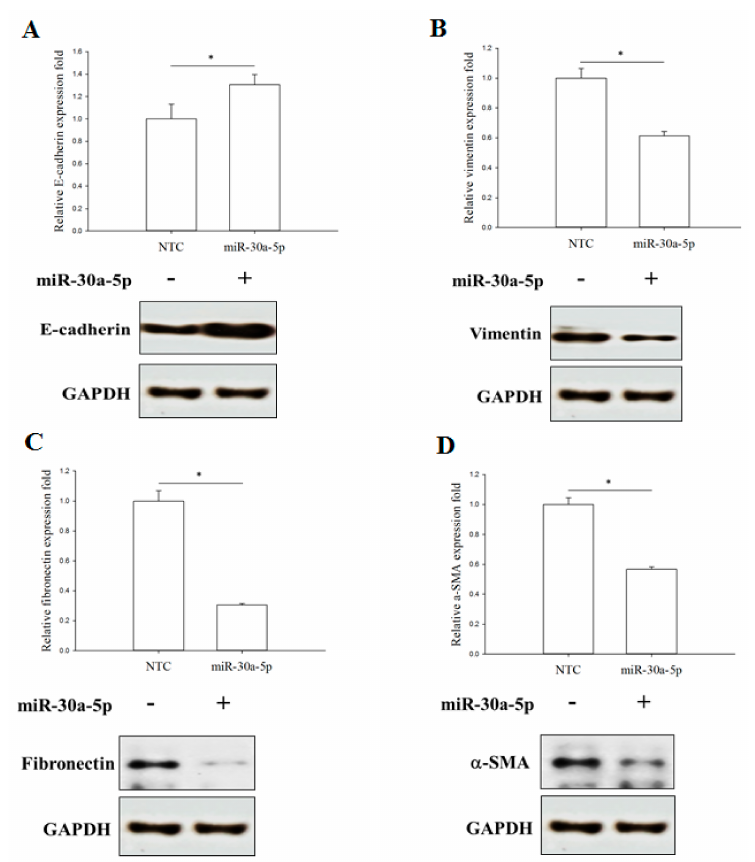
Figure 6. miR-30a-5p overexpression inhibits epithelial-to-mesenchymal transition marker expression in UTUC cells. Western blot analysis of expression levels of epithelial marker E-cadherin ( A ), and mesenchymal markers, including vimentin ( B ), fibronectin ( C ), and α -SMA ( D ) in cultured BFTC-909 cells transfected with miR-30a-5p or miR-NC. GAPDH was used as the loading control. Data are expressed as means ± SEM ( n = 3). * indicates that p < 0.05 between the indicated